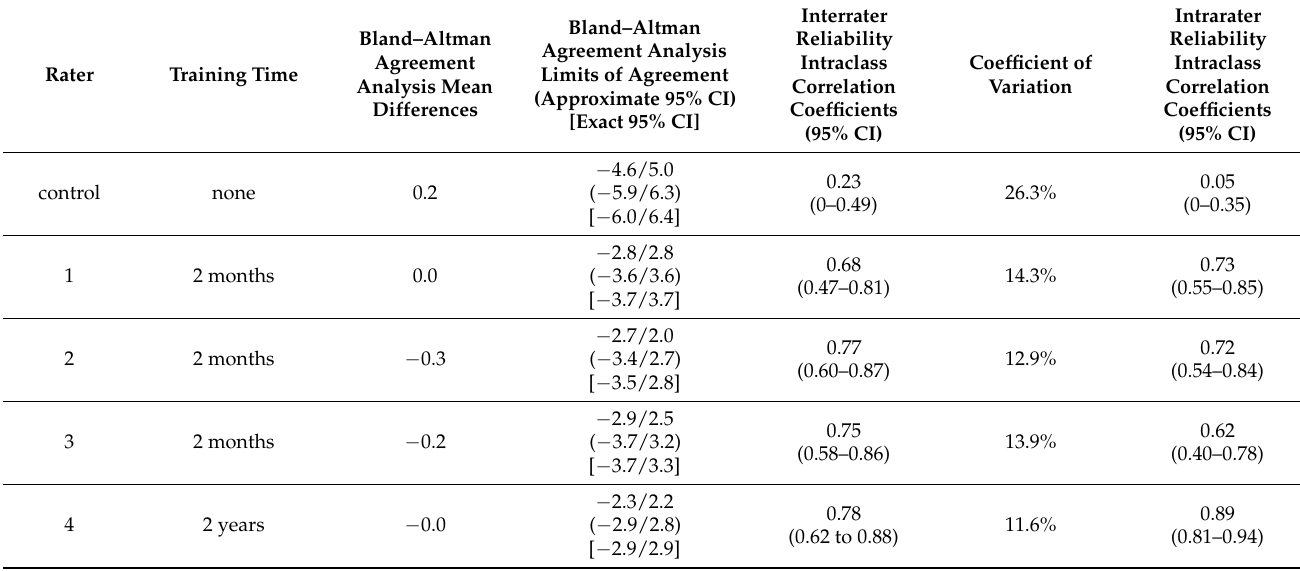
Table 2. Bland–Altman statistics, intraclass correlation coefficients for inter-and intrarater reliabilities, and the coefficients of